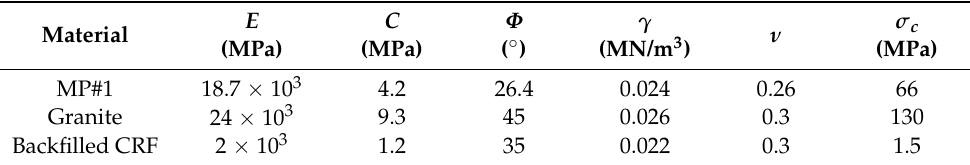
Table 1. Material properties.